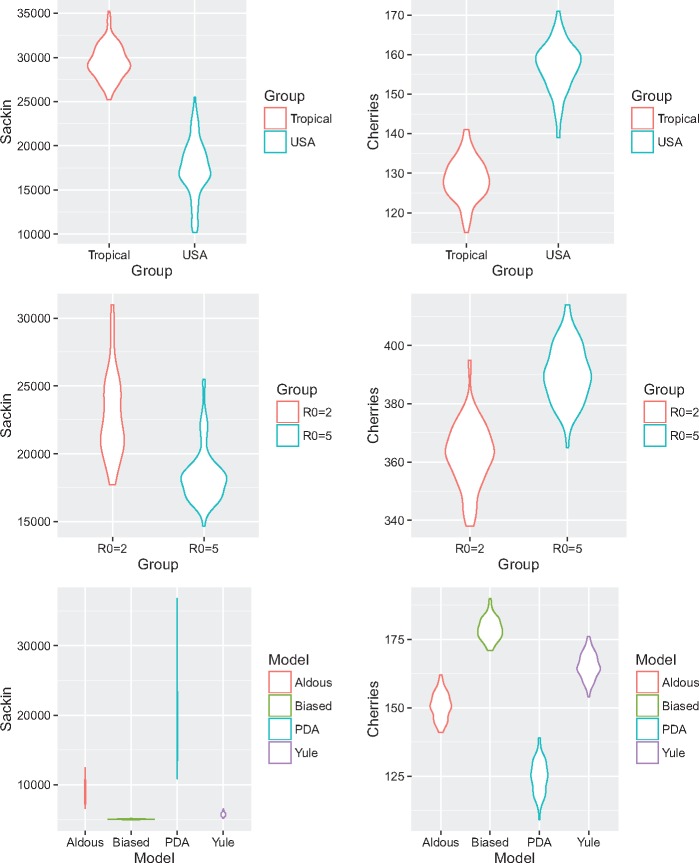
Two standard tree summary statistics, the Sackin imbalance and the number of cherry configurations, in the tropical and USA flu trees, the simulated birth–death trees with different values of the basic reproduction number \documentclass[12pt]{minimal}
\usepackage{amsmath}
\usepackage{wasysym}
\usepackage{amsfonts}
\usepackage{amssymb}
\usepackage{amsbsy}
\usepackage{upgreek}
\usepackage{mathrsfs}
\setlength{\oddsidemargin}{-69pt}
\begin{document}
}{}$R_0$\end{document} and in the trees from different random models.